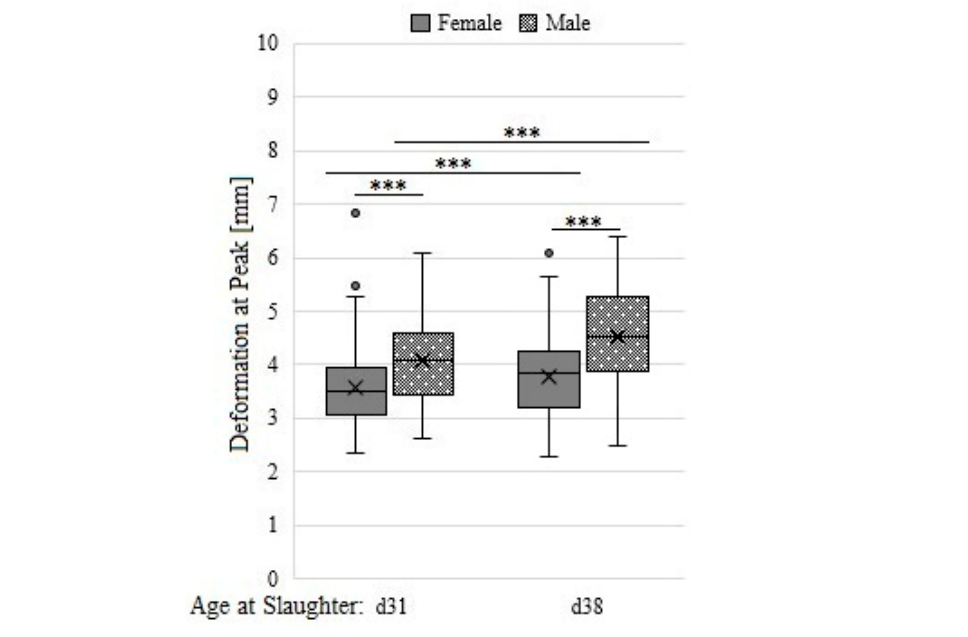
Figure 6. Effect of the interaction between sex (females presented in gray, males presented with patterns) and age at slaughter (day 31, day 38) on measured deformation at peak of the tibiotarsus (N = 445). Results are presented as boxplots (data range, median, lower quartile, and upper quartile; outliers are included in the graph as dots); significant differences between sex and age are marked by asterisks: *** p < 0.001 (Tukey–Kramer tests). Table 4. Left and right tibiotarsus weight, length, minimum diameter, peak force and deformation at peak on day 31 and day 38 for male and female